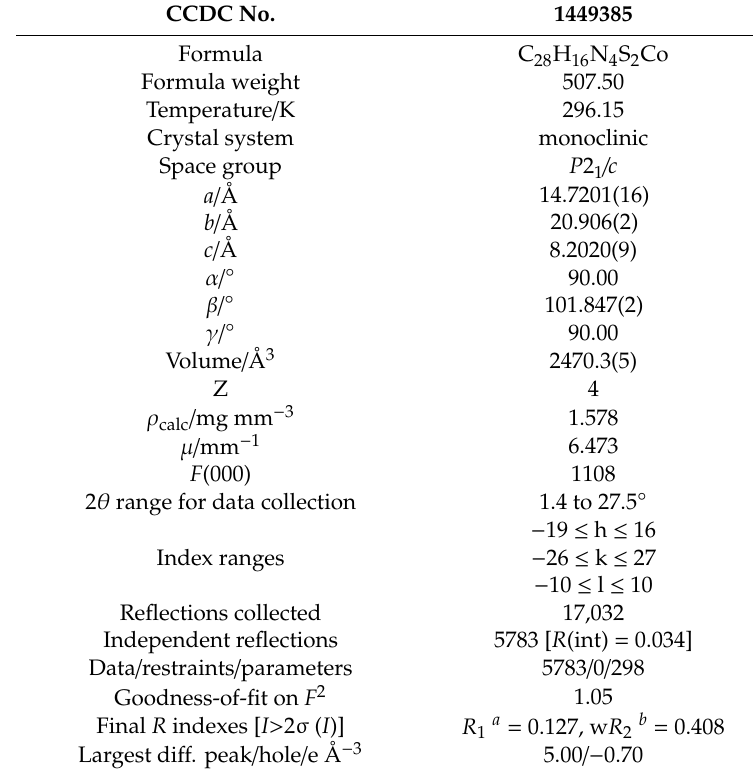
Table 1. Crystal structural data and refinement parameters for complex 1 .